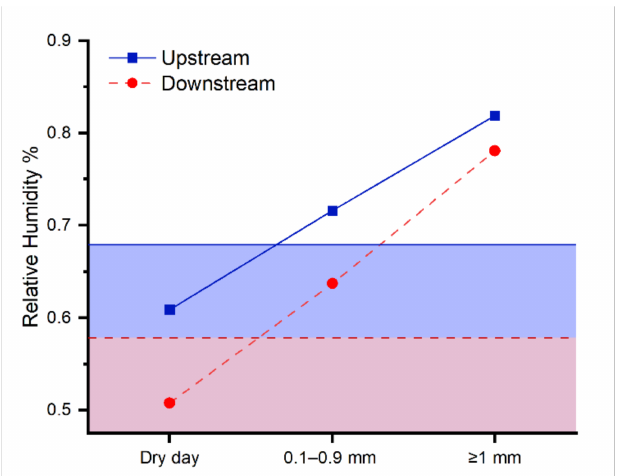
Figure 7. The average of relative humidity in different precipitation conditions in the upstream region and the downstream region from 1977 to 2017. The filled parts are the annual average of relative humidity; the blue fill is the upstream value, and the red fill is the downstream